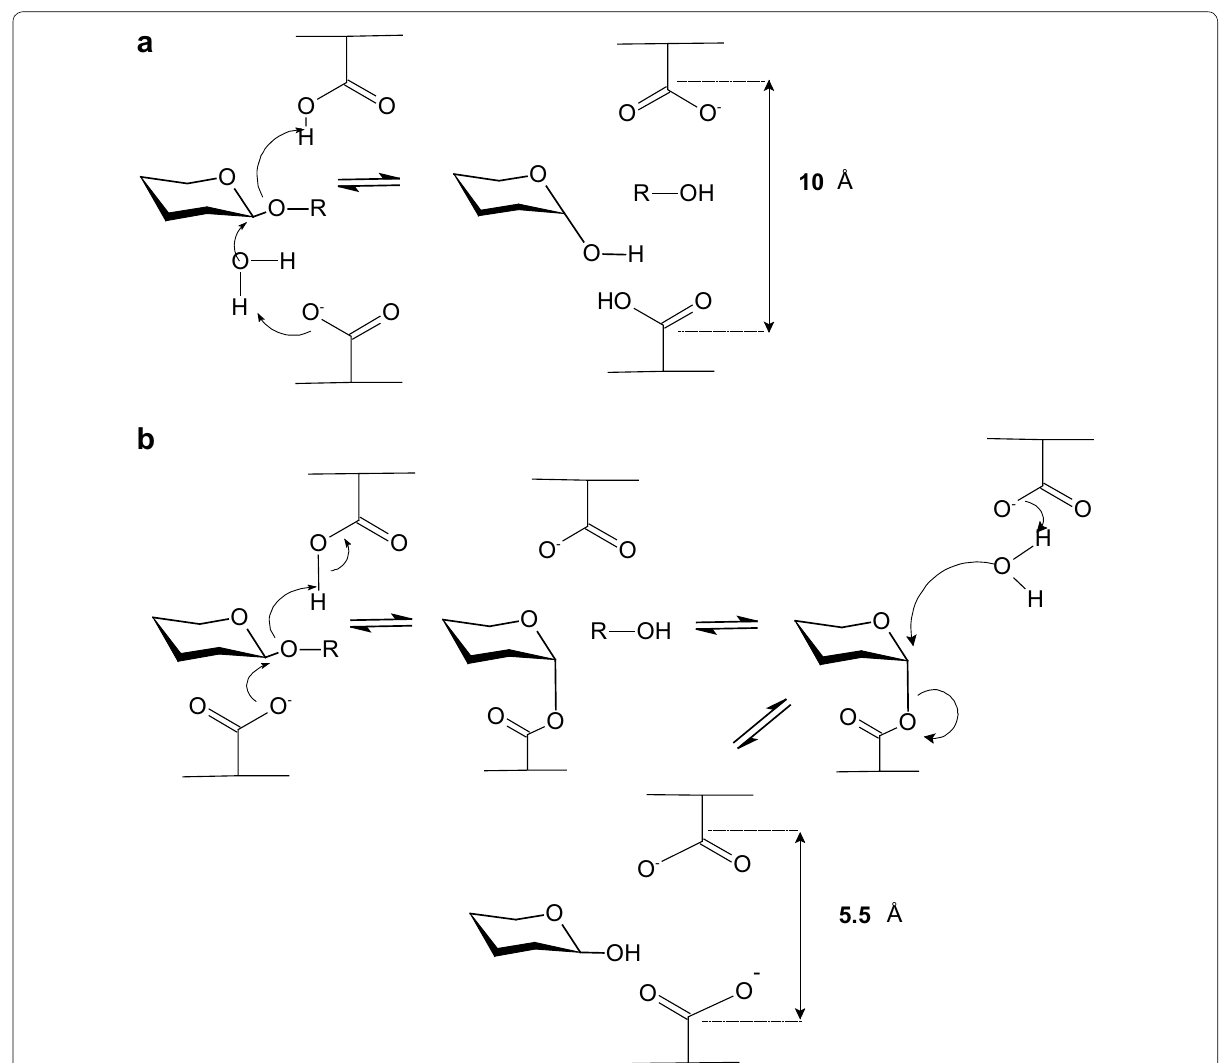
Fig. 1 The two major catalytic mechanisms of GHs, namely: the inversion ( a ) and retention ( b ) mechanisms. These two mechanisms lead to the effective hydrolysis of cellulosic substrates. The reader is referred to Zechel and Withers (2000) and Koshland (1953) for a detailed